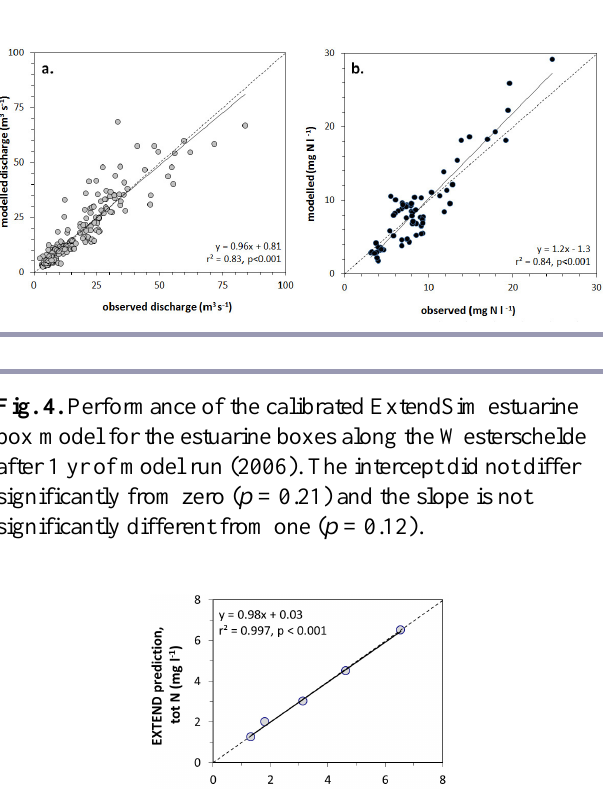
Fig. 3. Performance of the calibrated PCRaster model of the Scheldt for different stations (13) and years (6–20). (A) Observed vs. predicted discharge (196 observations, intercept not significantly different from zero: p = 0.243); (B) total nitrogen (73 observations, intercept p = 0.02).